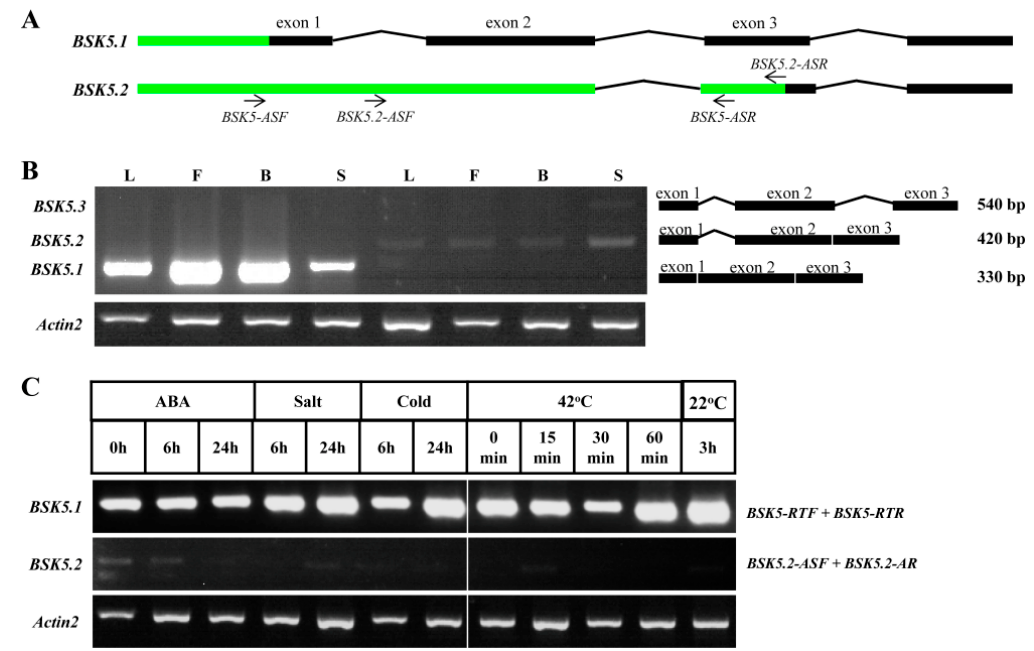
Figure 8. Alternative splicing analysis of BSK5 in Arabidopsis . ( A ) The scheme shows the primers (black arrow) used in the PCR. The black boxes represent exons, solid lines represent introns, and green boxes represent untranslated regions (UTRs). BSK5-ASF, BSK5.3-ASF: forward primers; BSK5-ASR, BSK5.2-ASR: reverse primers. ( B ) The mRNA corresponding to the three variants of BSK5 in different tissues was detected by RT-PCR. The numbers indicate the lengths (bp) of the spliced transcripts and schematic diagram outlining the organization of the transcript variants were on the right. L: leaves; F: flowers; B: buds; S: siliques. ( C ) RT-PCR analysis of the expression profiles of BSK5 variants under stress treatment.